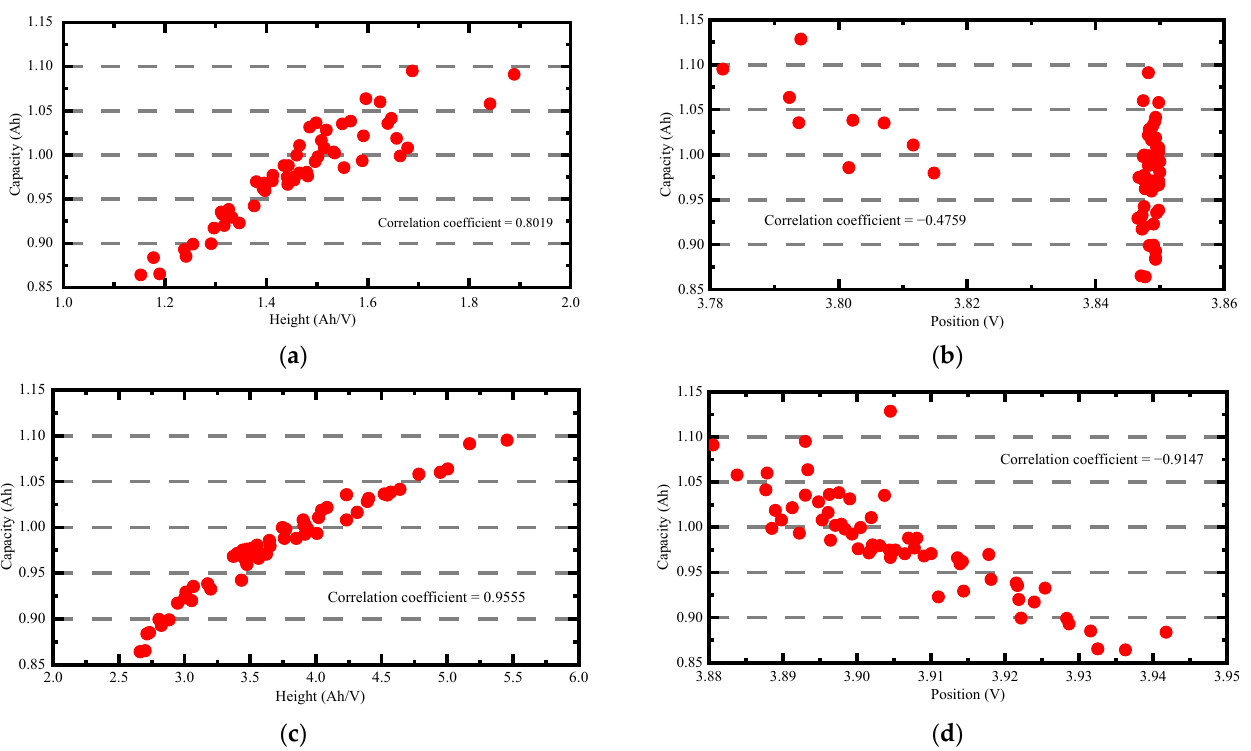
Figure 6. The degree of correlation between HIs and capacity . ( a ) Ⅰ peak value vs. capacity; ( b ) Ⅰ peak